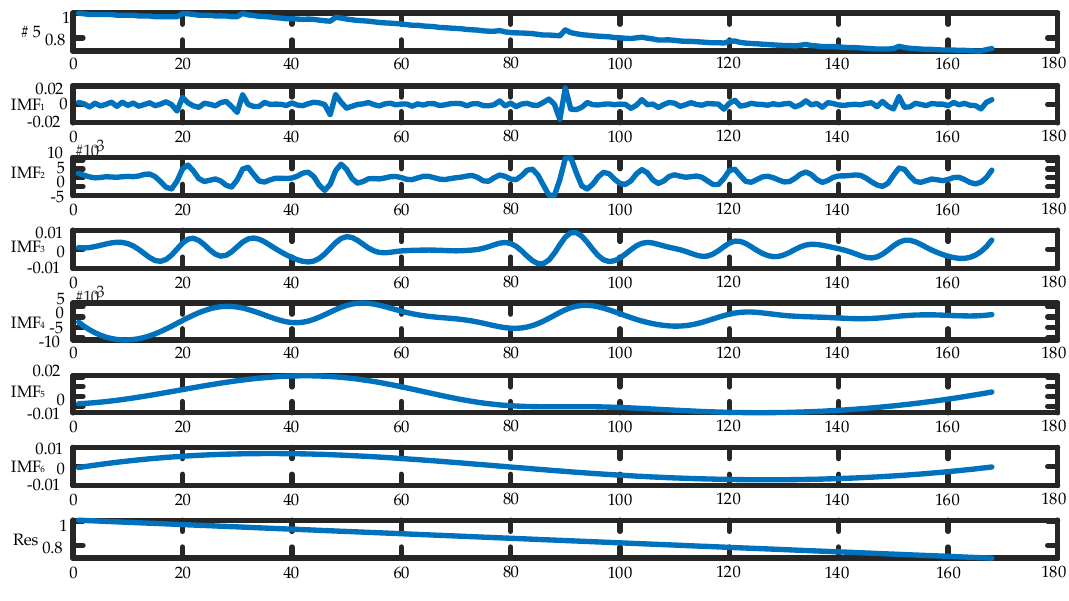
Figure 3. The results of EEMD for #5 battery capacity.